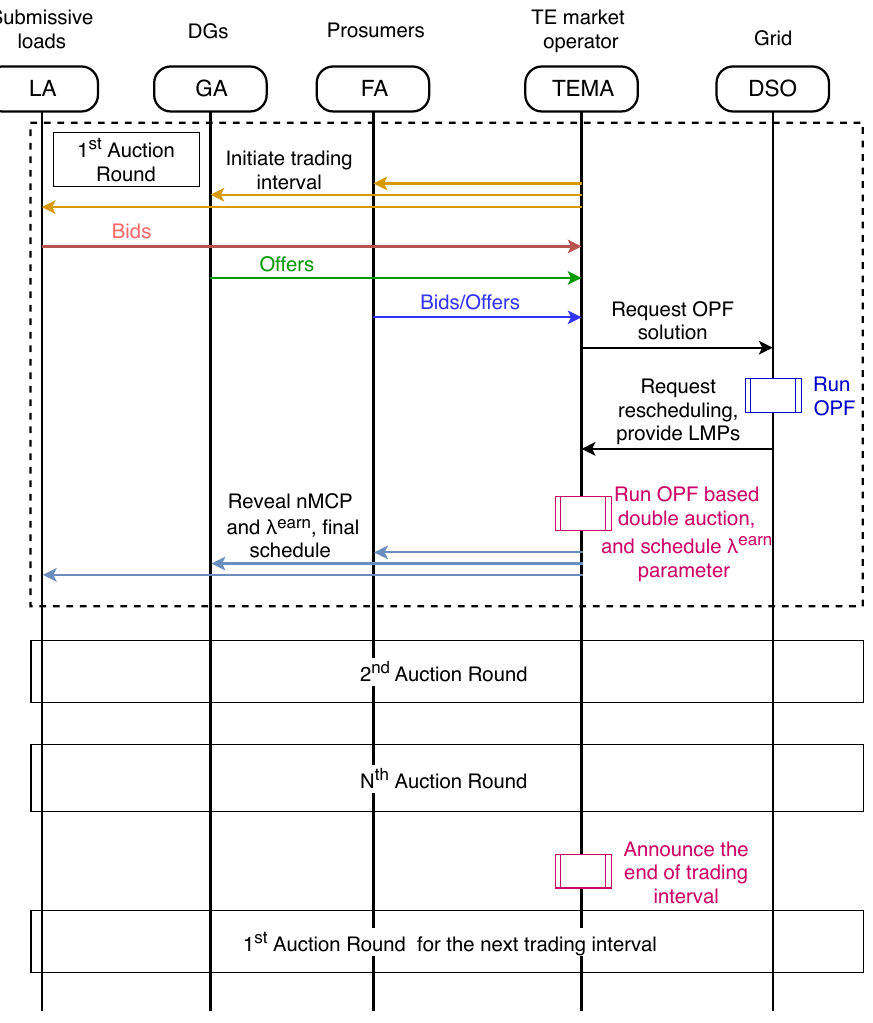
Figure 2. Data exchange layout for the agents in the proposed distribution locational marginal price (DLMP) based TE management system